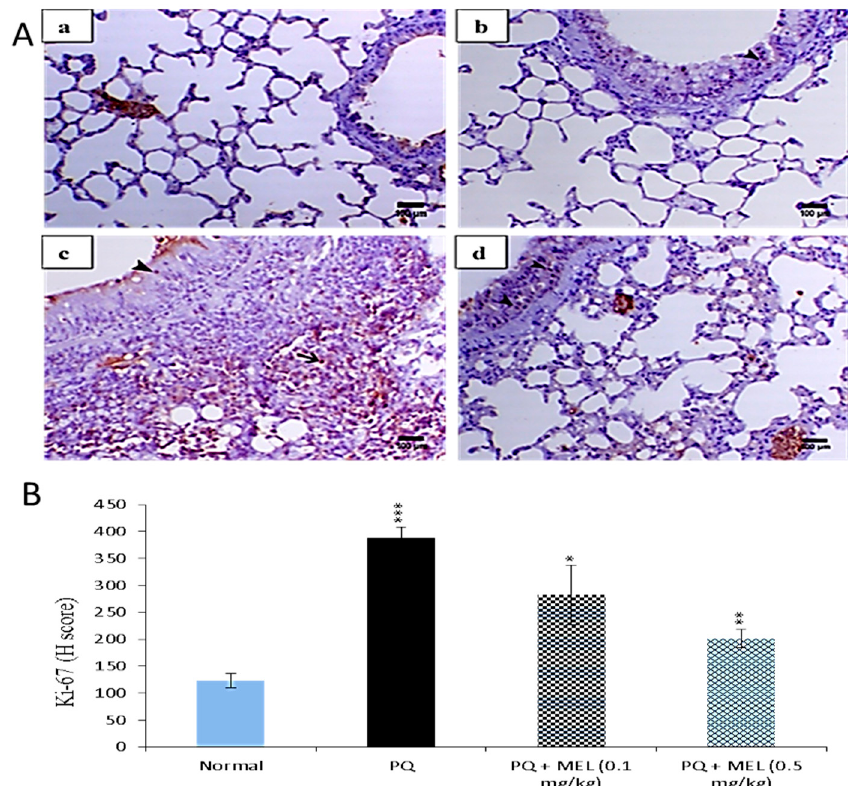
Figure 9. Effect of treatment with melittin (MEL) on Ki-67 protein level in lung tissues. A : Representative lung immunohistochemical graphs (a: control group, b: paraquat (PQ) group, c: PQ + MEL (0.1 mg/kg) group, d: PQ + MEL (0.5 mg/kg) group); ( a ) showed mild expression of Ki-67 immunostaining within the alveolar and bronchial lining epithelium (arrow). ( b ) presented an obvious increase in the inter- alveolar septa (arrow) as well as in the necrotic epithelial bronchial lining (arrowhead). ( c ) illustrated a marked decrease in Ki-67 expression within the alveolar and bronchial epithelium (arrowhead). ( d ) indicated a noticeable decline in Ki-67 expression within the alveolar and bronchial epithelium (arrowhead). Magnification = X200 and scale bar = 100 µm. B : Statistical analysis of Ki-67 H-score. Data